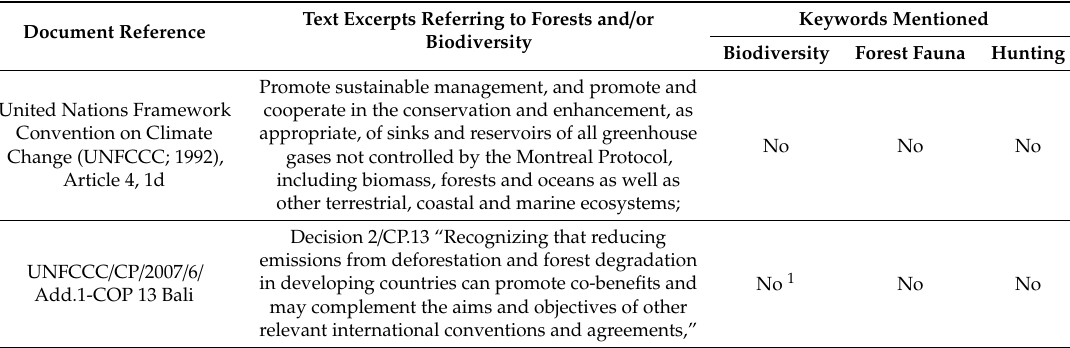
Table 1. Biodiversity in UNFCCC documents and decisions on forests and REDD +